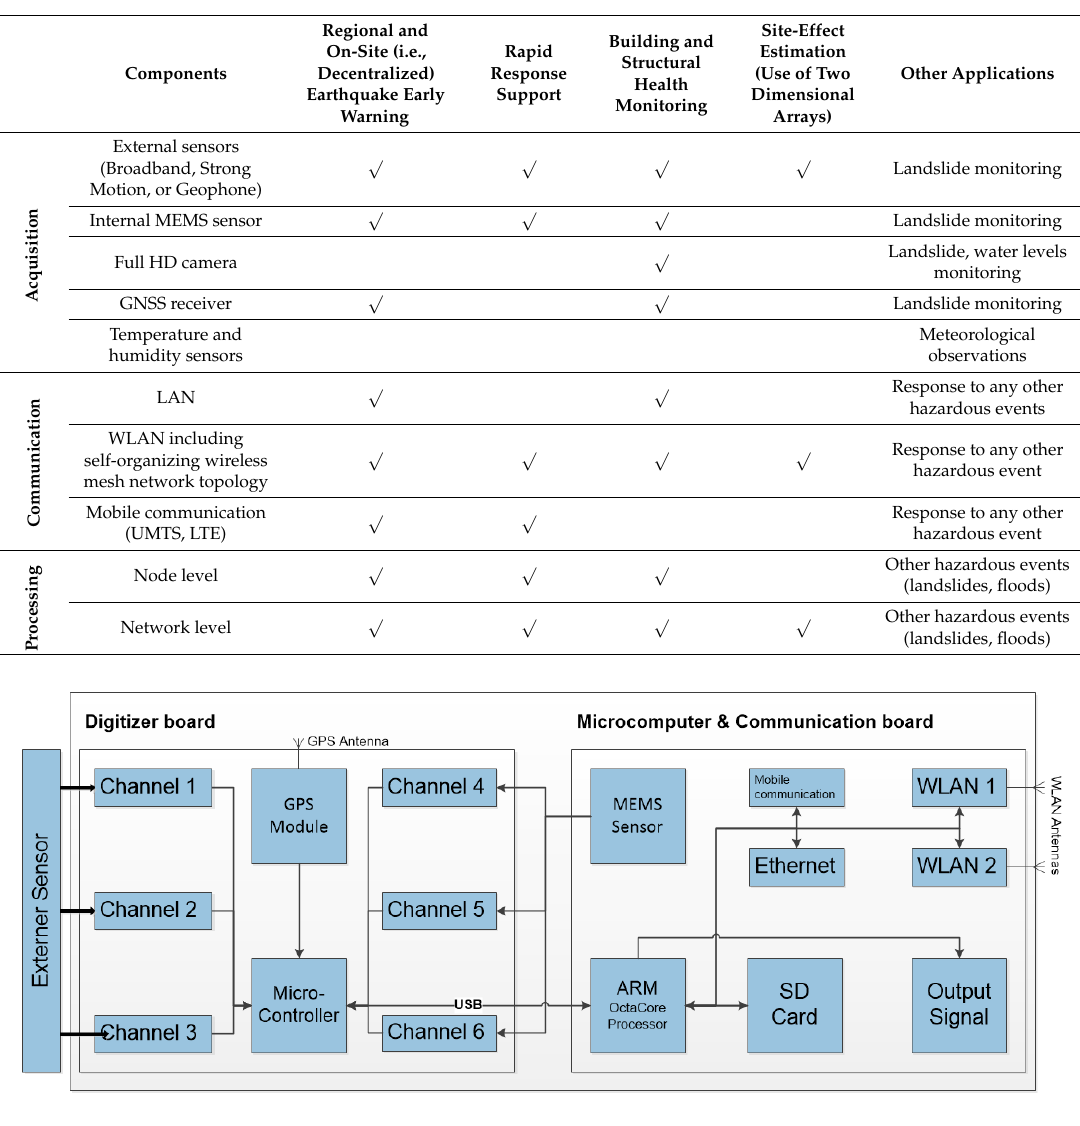
Figure 2. General schema of the MPwise units, showing the three main components: the digitizer board (see Table 3), the microcomputer (which includes the communication periphery, see Table 4) and the links to the internal and external sensors. Table 3. Technical specifications of the digitizer board.